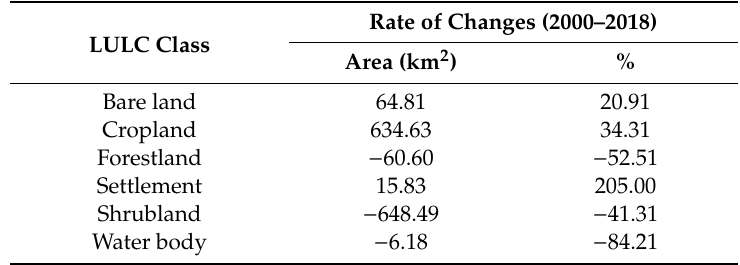
Table 4. Temporal change in the spatial extent of LULC classes in percentage